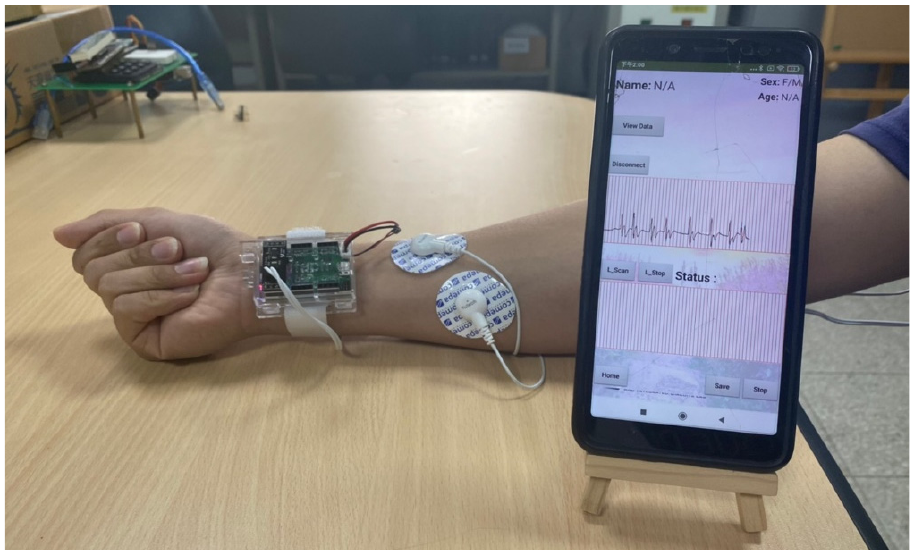
Figure 11. Electrode position stereogram.